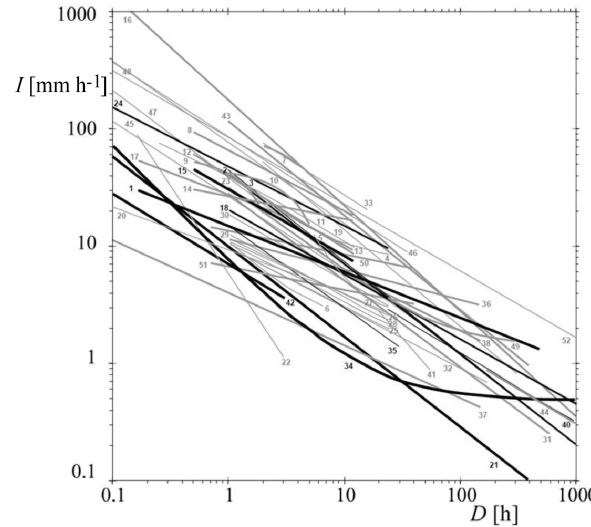
Figure 1. Examples of intensity-duration-frequency curves for a 10- year return period (1–9) and curve of the maximum observed pre- cipitation (10). Location and source: 1 – Najran region, Saudi Ara- bia (Elsebaie, 2012); 2 – Uccle, Belgium (Van de Vyver, 2015); 3 – Naples, Italy (Rossi and Villani, 1994); 4 – Los Angeles, California (Wenzel, 1982); 5 – Pelotas, Brazil (Damé et al., 2016); 6 – New York (Wenzel, 1982); 7 – Hamada, Japan (Iida, 2004); 8 – Selan- gor, Malaysia (Chang et al., 2015); 9 – Sylhet, Bangladesh (Rasel and Hossain, 2015); 10 – greatest known observed point rainfall (Brutsaert, 2005).